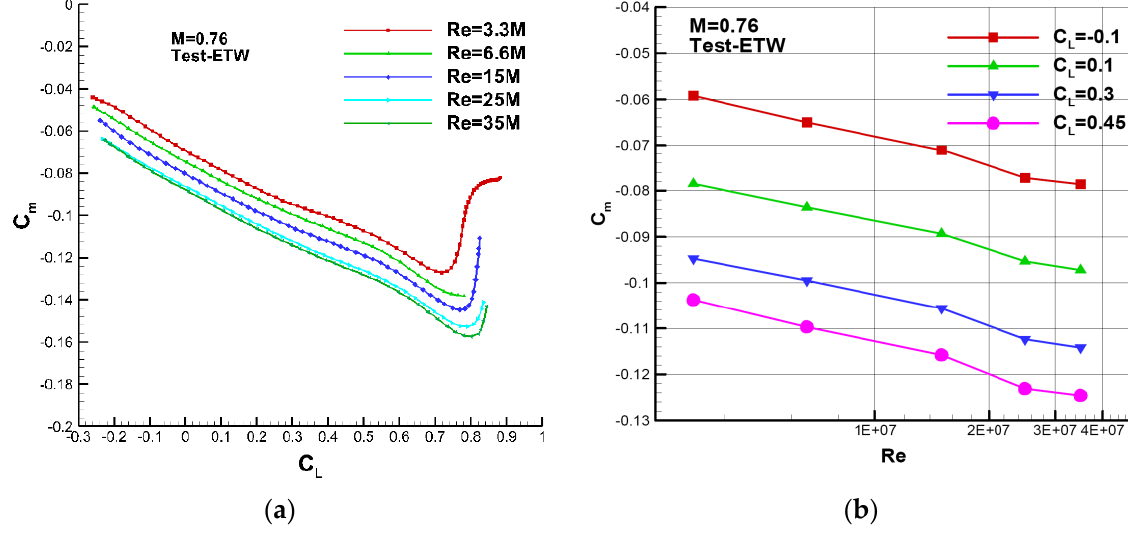
Figure 20. Pitch moment coefficient and polar curves at different Reynolds number: ( a ) polar curves; ( b ) pitch moment coefficient.